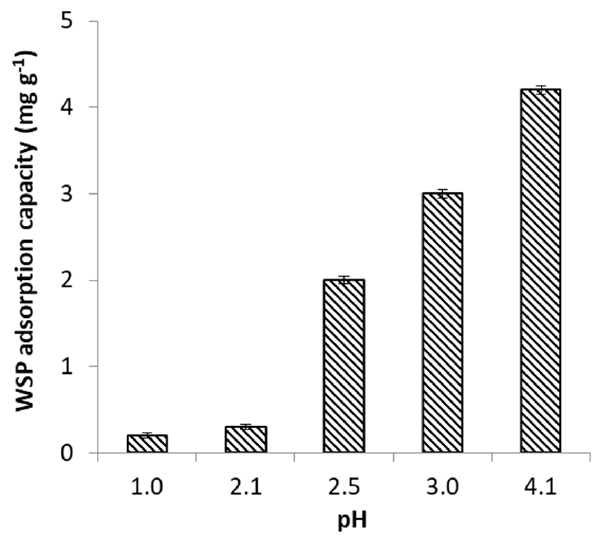
Figure 2. Effect of pH on Fe II adsorption capacity of WSP.